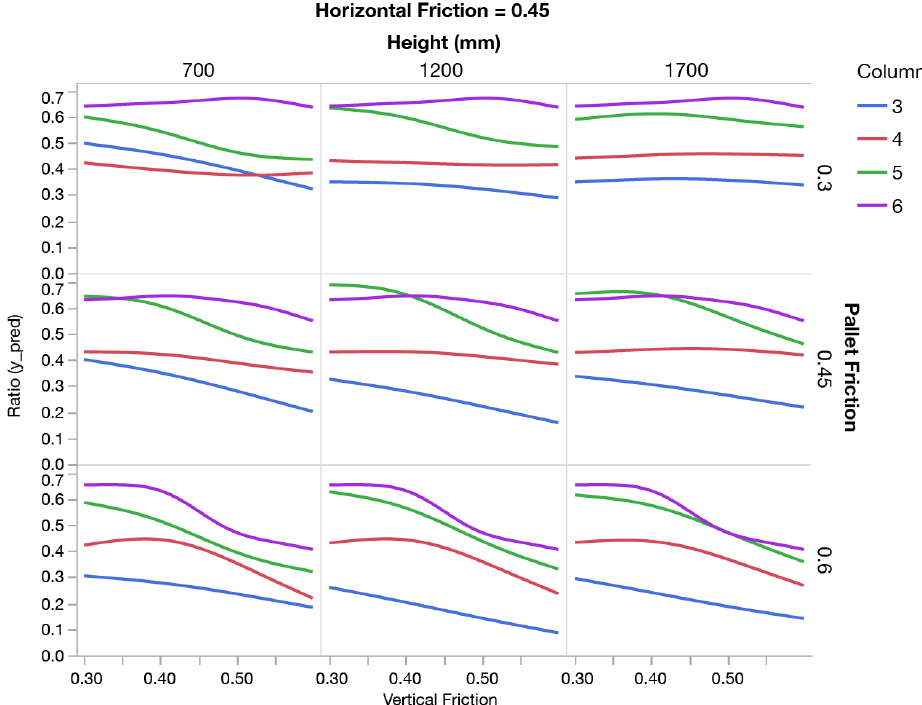
Figure 14. Effect of the friction coefficient of the vertical surface of the packages on board bending ratio by pallet friction, payload height (mm), and number of columns, with a fixed coefficient of friction of the horizontal surface of 0.45.